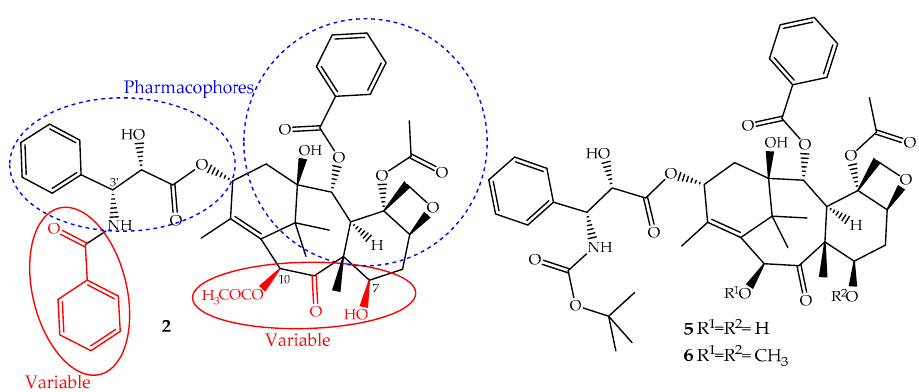
Figure 3. The parts of the paclitaxel ( 2 ) structure that could be modified without loss of activity and two of its derivatives, docetaxel ( 5 ) and cabazitaxel ( 6 ), available on the market for clinical use.